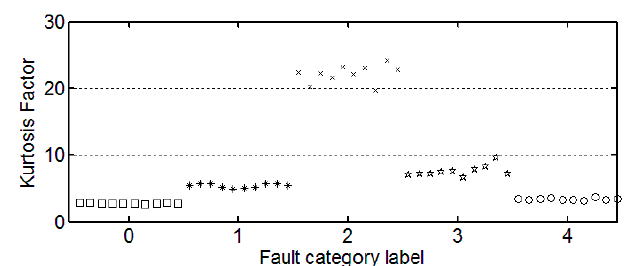
Figure 7. The trend of kurtosis factor.